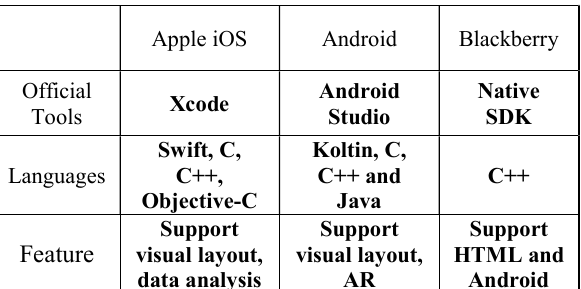
Table 1 A short summary on major mobile platforms.